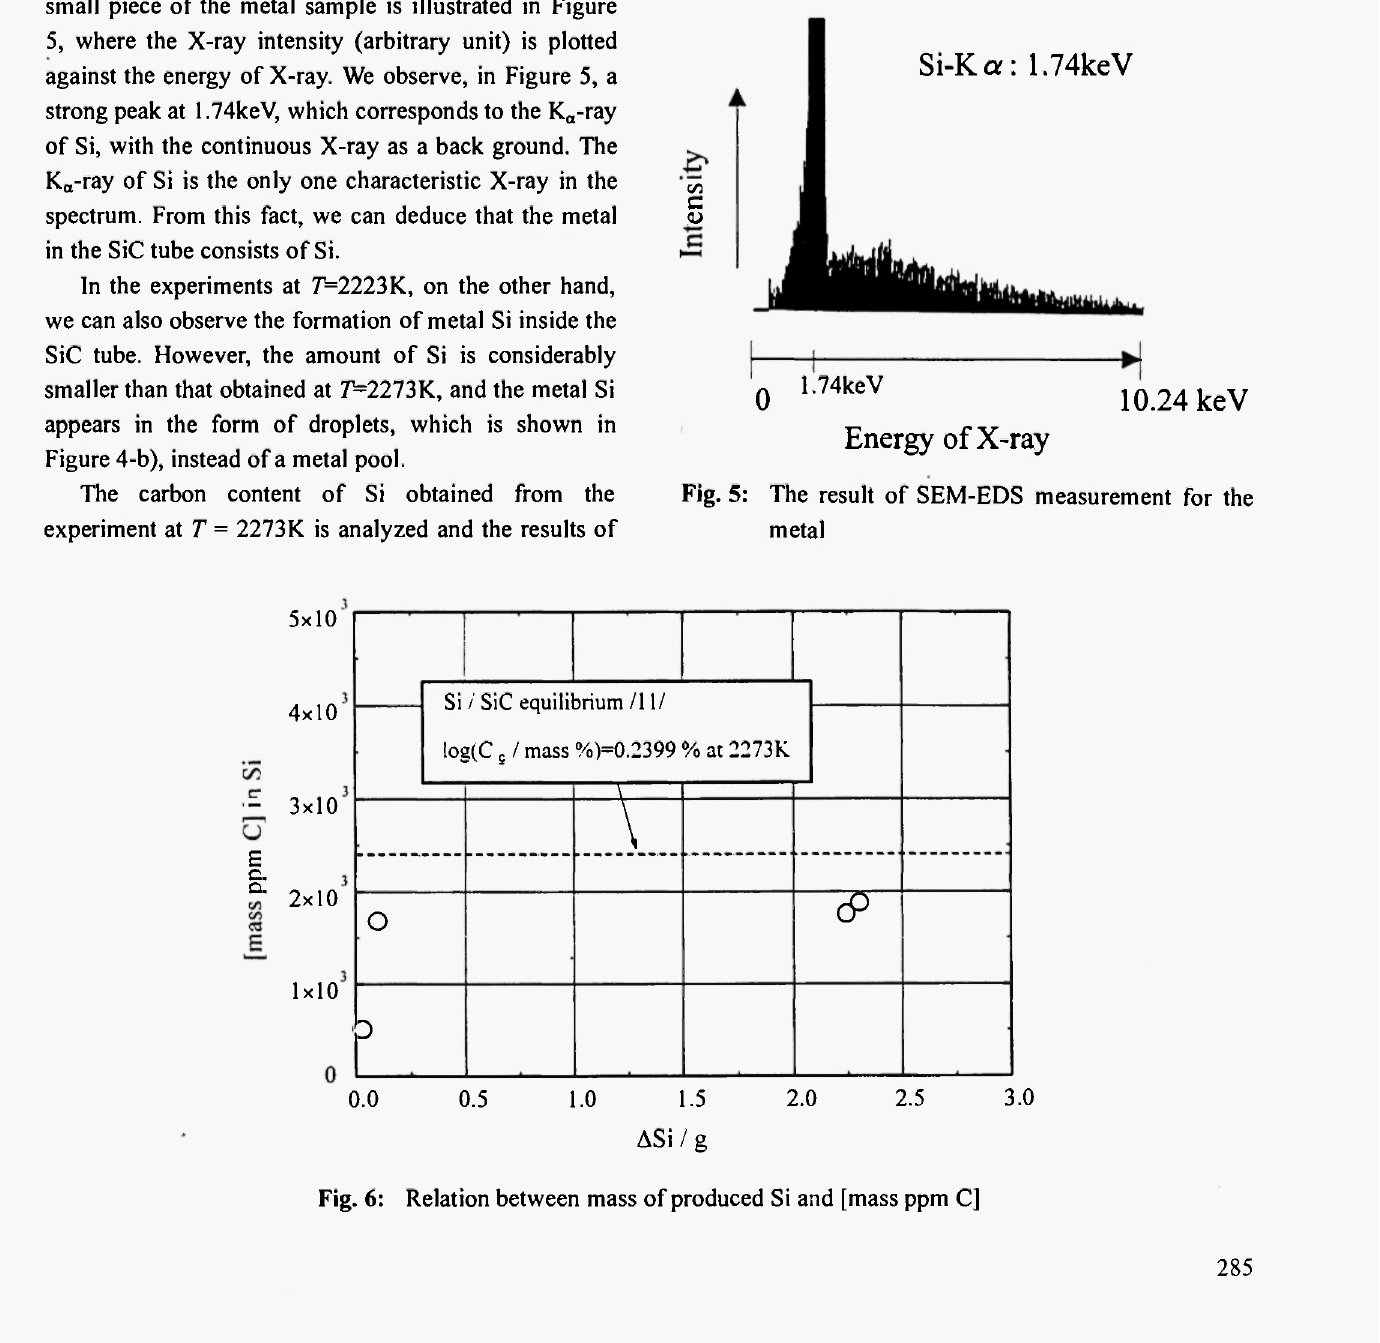
Fig. 5: The result of SEM-EDS measurement for the